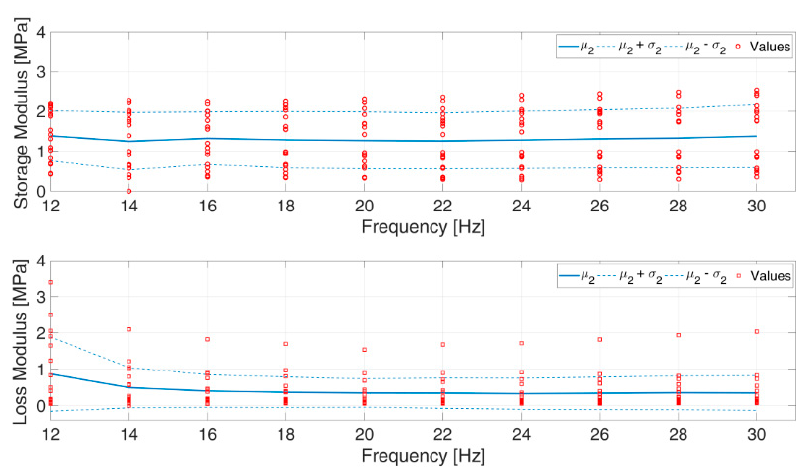
Figure 4. Spread of elastic, E e , and loss modulus, E l , data of bovine tissue from various ovaries.